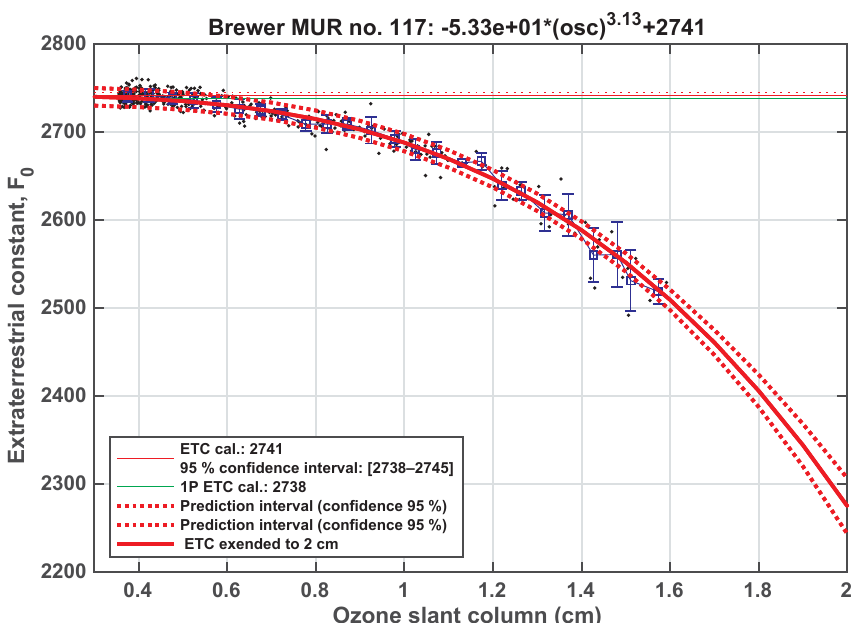
Figure 4. The stray light parameters k and s are determined by a non-linear fit using the ETC determined from the stray-light-free region as first-guess parameters. The red horizontal lines indicate the ETC constant retrieved from the fit, and the green one indicates the initial guess. The upper and lower 95% prediction bounds are also displayed in red dot lines.